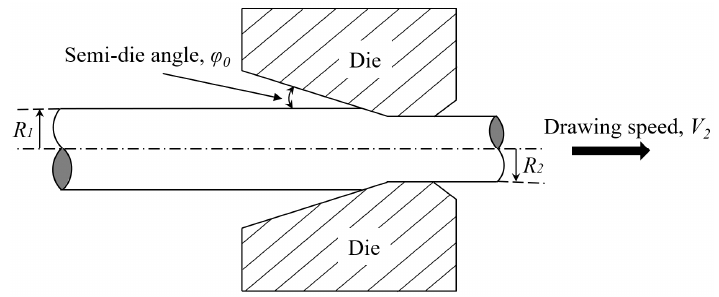
Figure 1. Schematic diagram of the process.